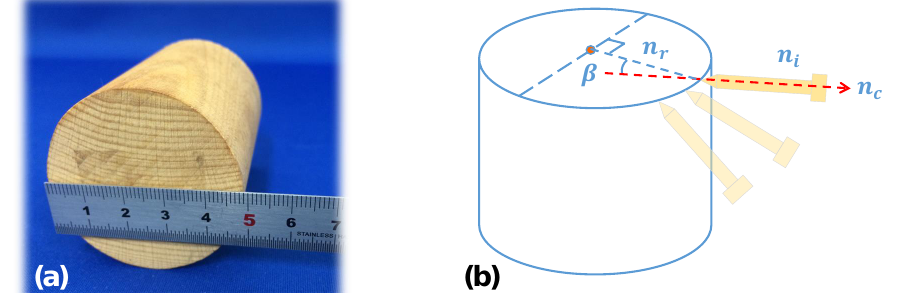
Figure 5. The previous method of pose evaluation. ( a ) Photos of the tested object. ( b ) Calculation of the angle